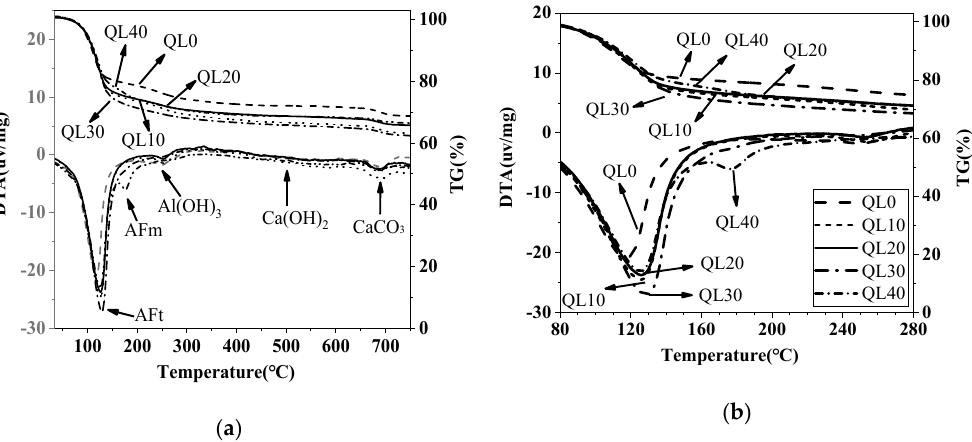
Figure 16. TG-DTA curves of the double liquid grouting materials with different quicklime content at 28 days: ( a ) Temperature ranges from 40–750 °C; ( b ) Temperature ranges from 80–280 °C. Table 7. Weight loss of the double liquid grouting materials with different quicklime content.